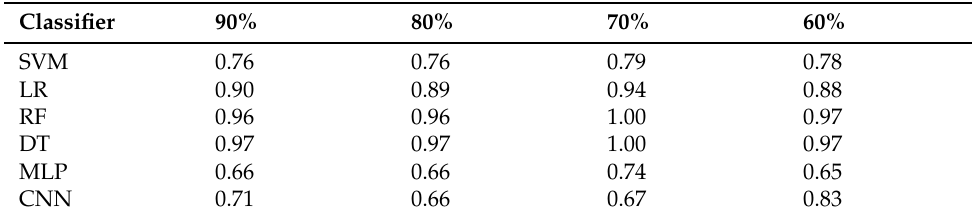
Table 7. Results of training accuracy for all